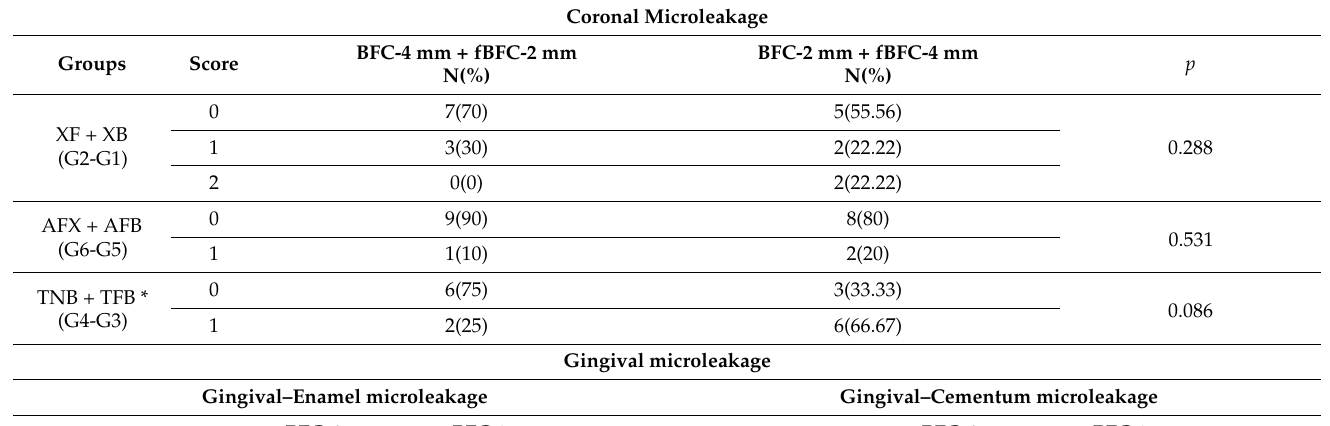
Table 2. Evaluation of microleakage scores according to groups. Coronal